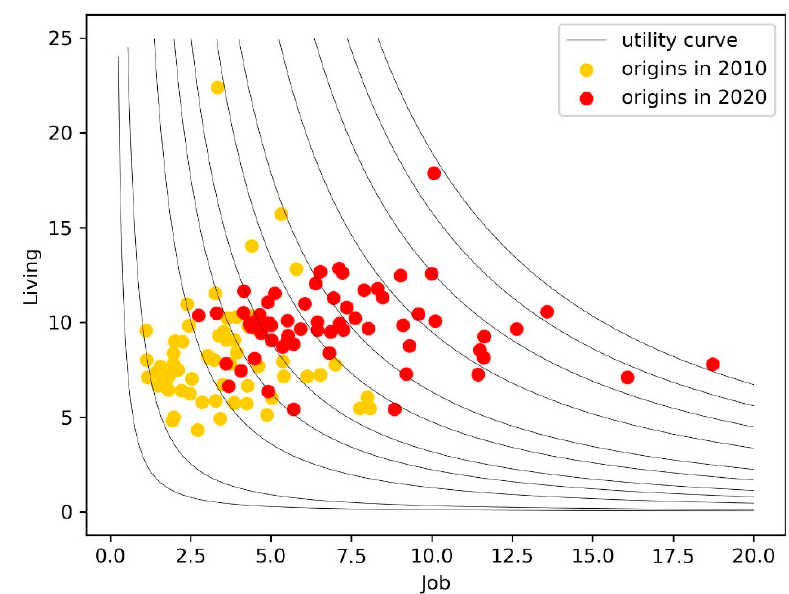
Figure 5. Utility curves and origin conditions of immigrants.